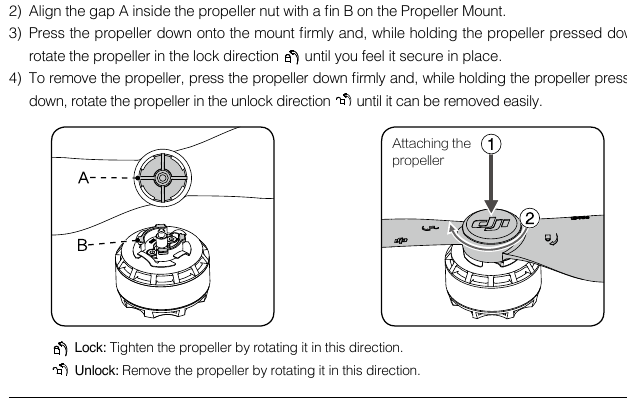
CW CCW Propeller Mount